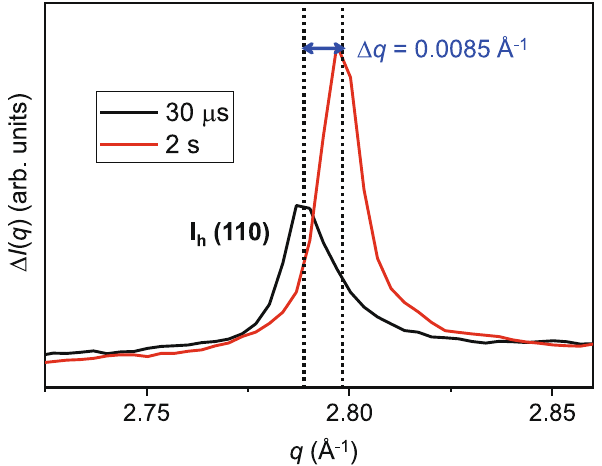
Fig. 6 | Bragg peak shiftin ice following laserheating. Ice I h (110)peakpositions measured at 30 μ s (black) and 2 s (red) after laser excitation of the sample. The shown peak shift of 0.0085 Å − 1 corresponds to a temperature difference of approximately 90 K in ice I h . As described in the text, this temperature change implies that the temperature of the LDA sample was increased by 60 K by the IR laser pulse, prior to